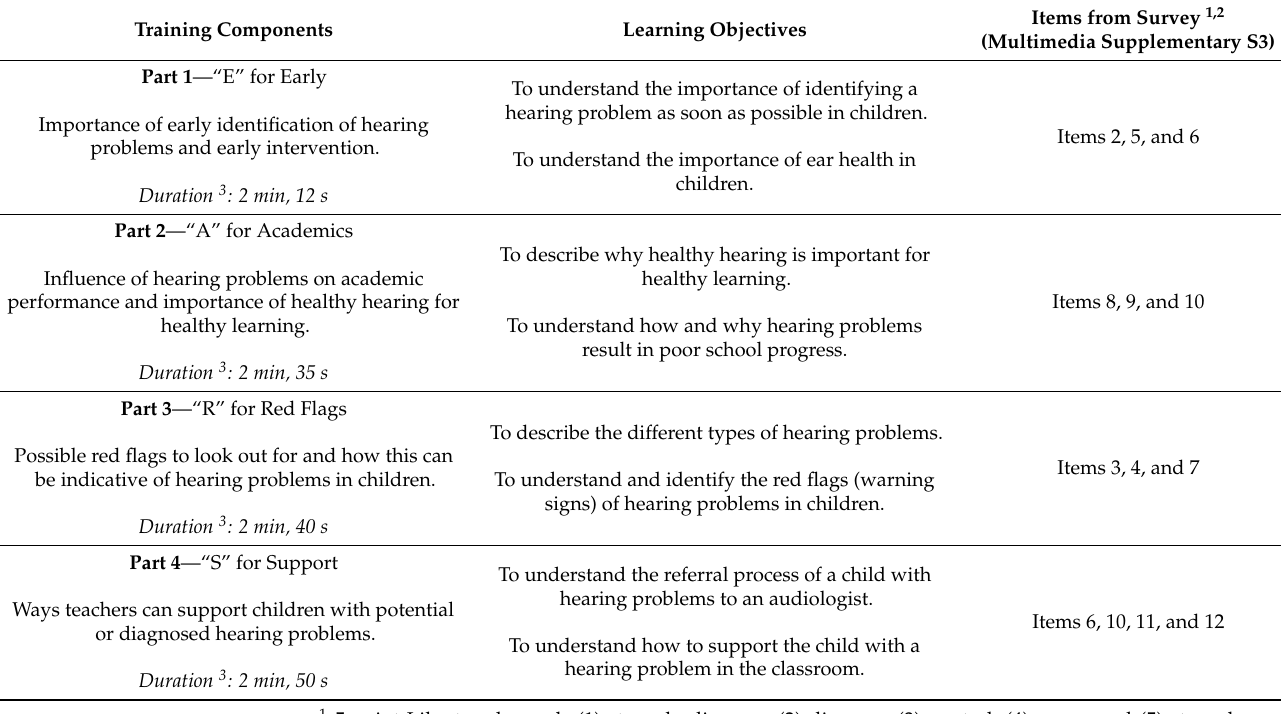
Table 1. Training description and learning objectives with survey